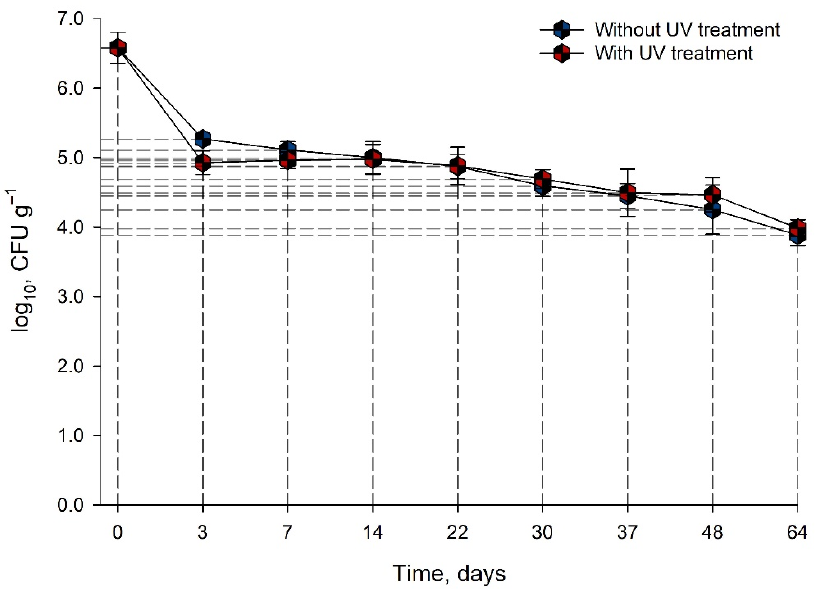
Figure 4. Survival behavior of Salmonella spp. in feed stored at 17 °C, with and without constant exposure to UV radiation. exposure to UV radiation.